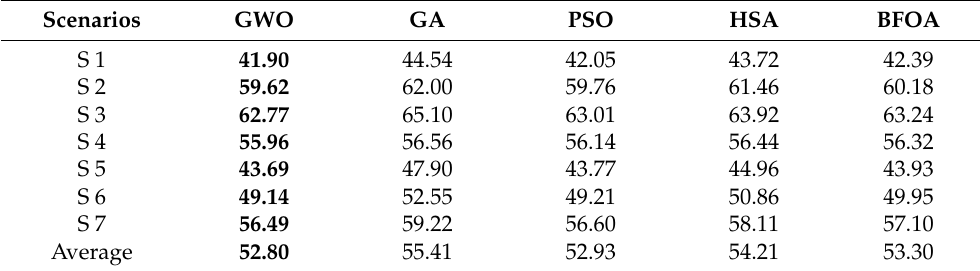
Table 13. Comparison between the five algorithms in terms of EB